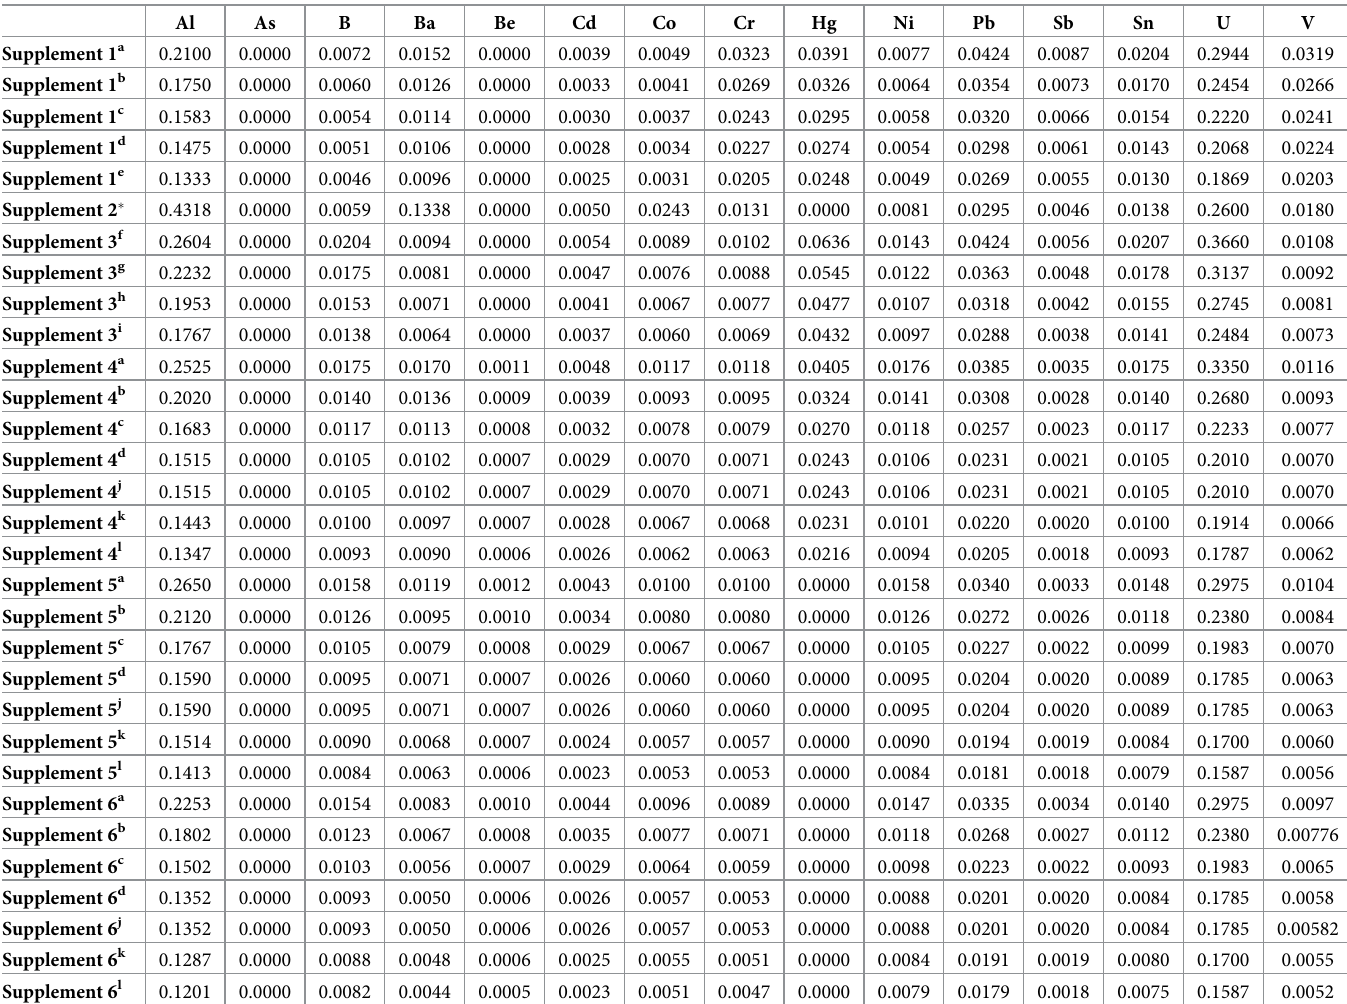
Table 2. Quantities of toxic metals in mg/kg of body weight provided by each supplement for dogs and